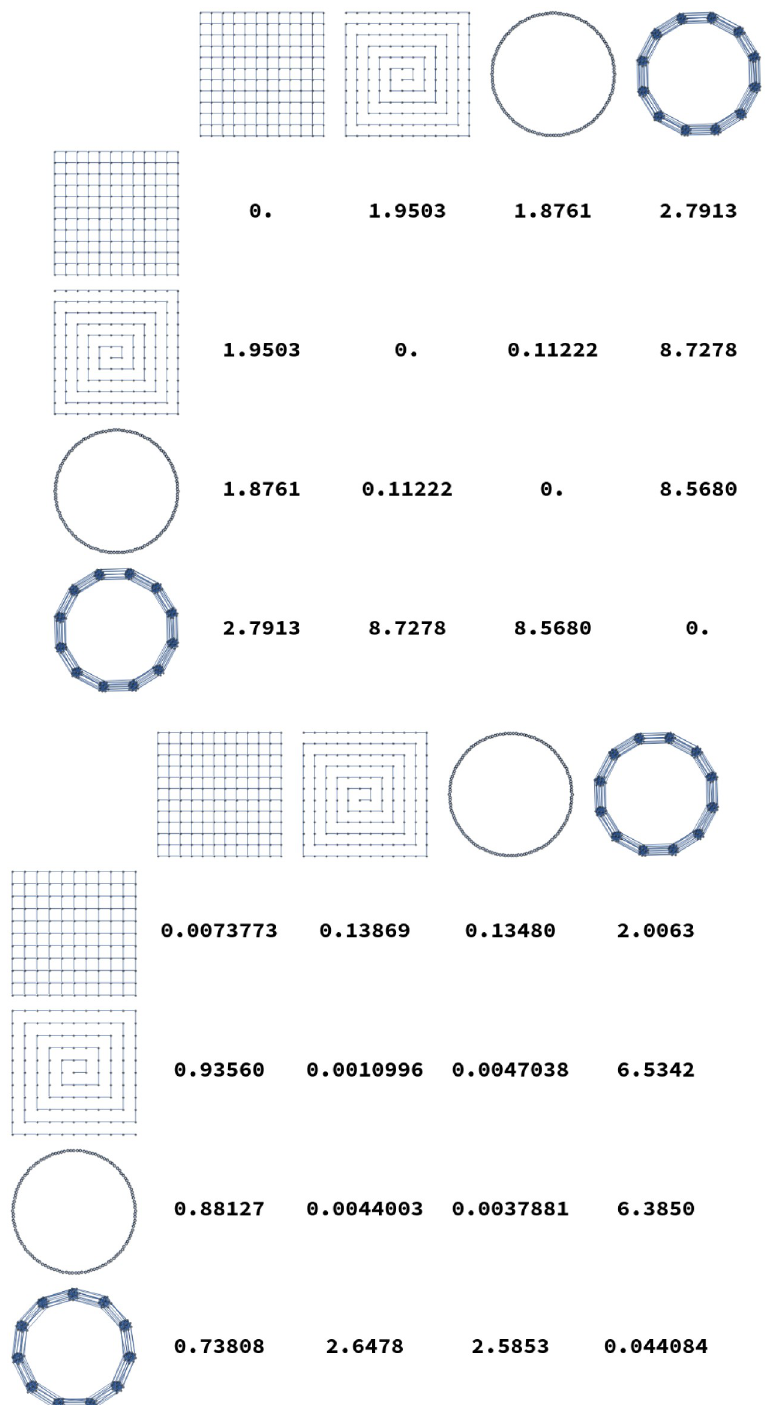
Fig 6. Distances D 2 ( G , H ) calculated for several pairs of graphs. The top plot shows distances where G and H are both chosen from {Grid 13 , P 169 , C 169 , Ba 13 }. At bottom, distances are calculated from G chosen in {Grid 12 × 13 C 144 , Ba 12 } to H chosen in {Grid 13 × 13 , P 169 , C 169 , Ba 13 }. As expected, diagonal entries are smallest.